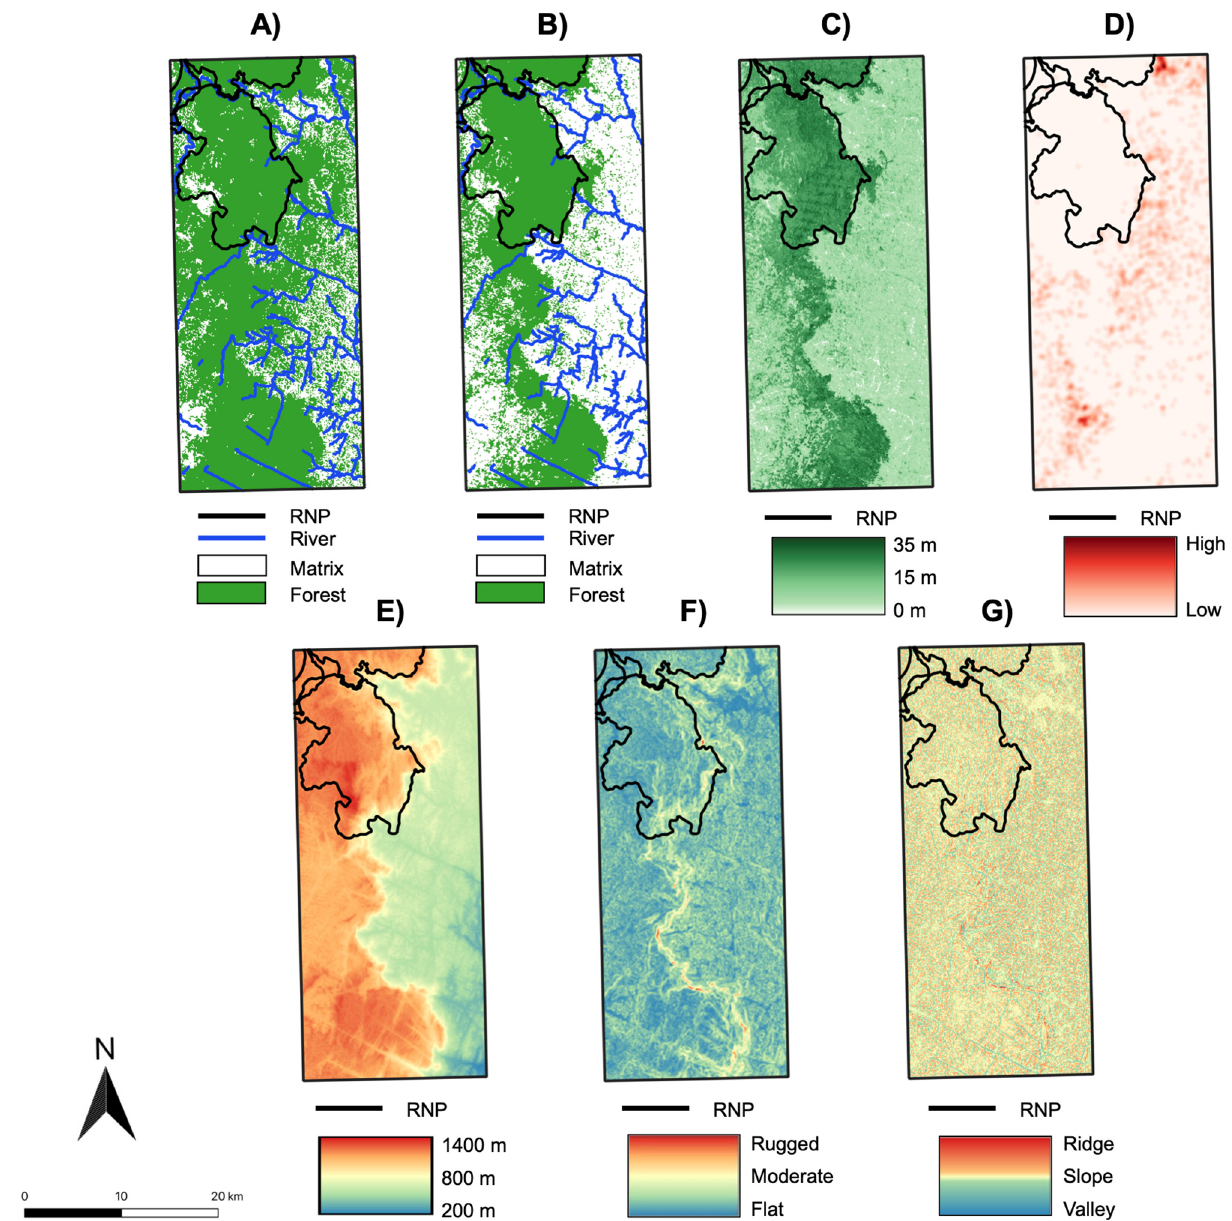
Figure 2. Maps of Ranomafana region showing landscape surfaces for ( A ) 1990 (historic) forest cover and rivers; ( B ) 2016 (contemporary) forest cover and rivers; ( C ) 2019 canopy height; ( D ) fire density; ( E ) altitude; ( F ) terrain ruggedness index (TRI); and ( G ) topographic position index (TPI).